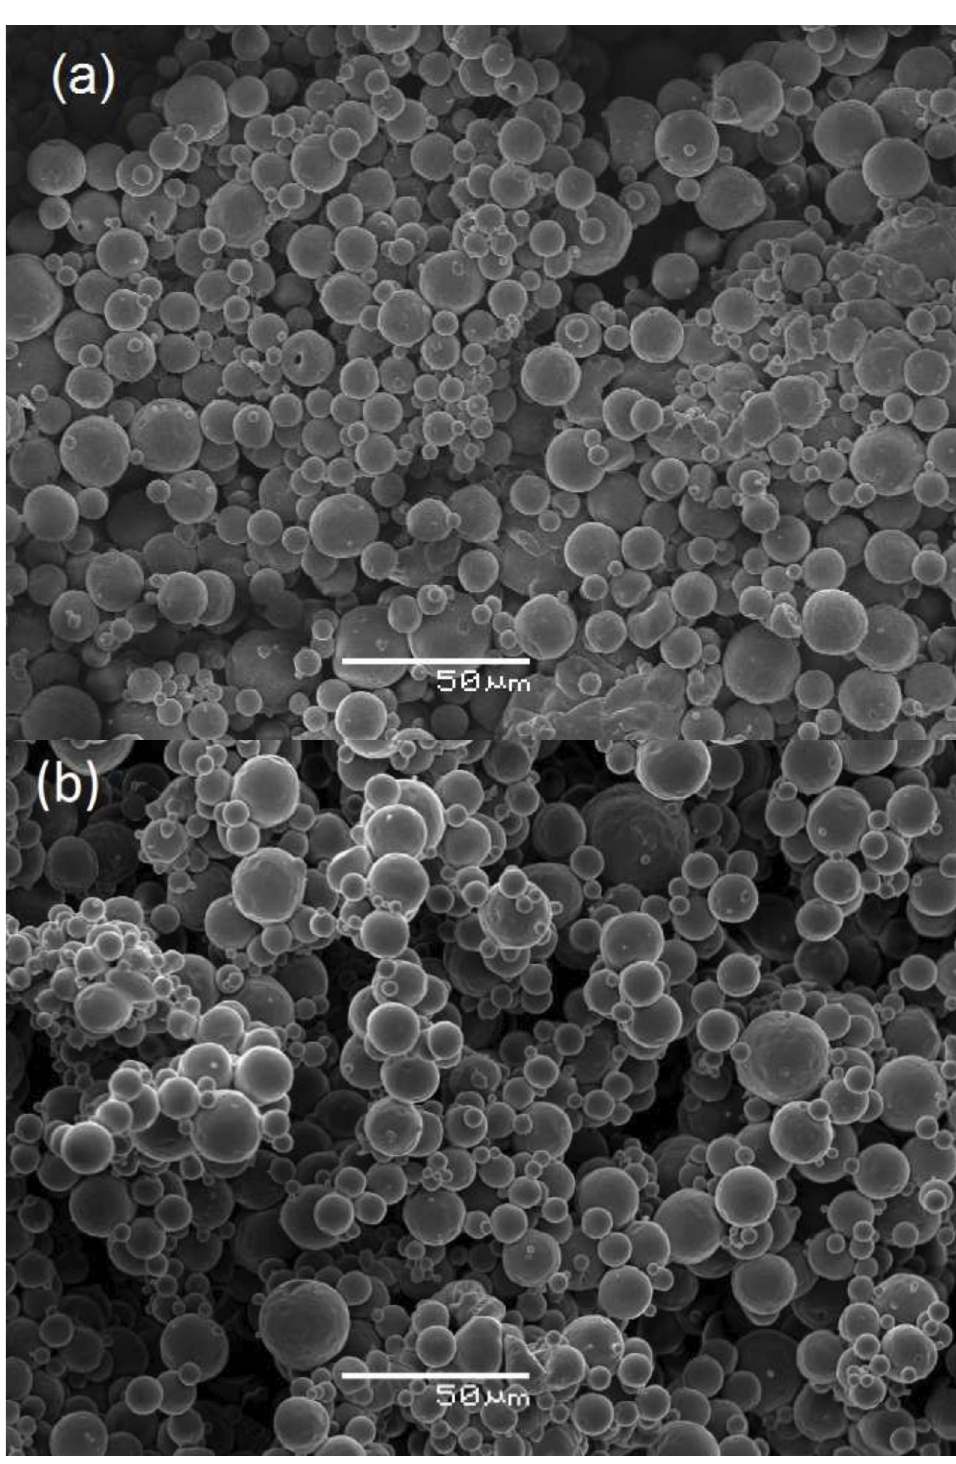
Fig 3. Scanning electron microscopy. Scanning electron micrographs of PCL microparticles: (a) MC3 and (b) MC5